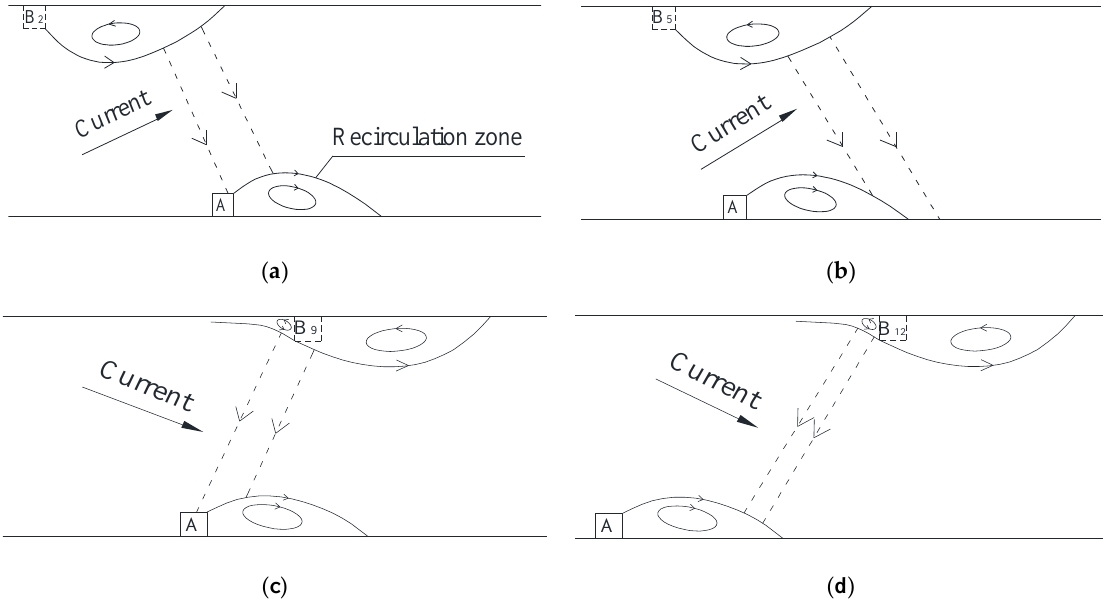
Figure 17. Schematic diagram of the influence of Groin B on the backflow behind Groin A in different cases, ( a ) Groin B in the upstream far-field of Groin A, ( b ) Groin B in the upstream near-field of Groin A, ( c ) Groin B in the downstream near-field of Groin A, ( d ) Groin B in the downstream far-field of Groin A.